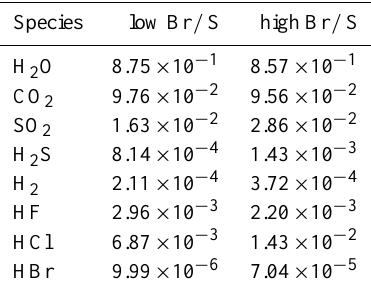
Table 4. Fractional composition (by volume) of pure volcanic volatiles of Mt. Etna in June 2012 (“low Br / S”) and in 2005 (“high Br / S”). These compositions were used to initialise the HSC calcu- lations (for results see Table S1). “High Br / S” refers to the plume composition used in von Glasow